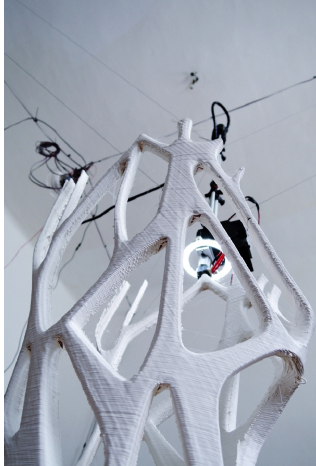
Figure 20. Parallel cable printer processing large object.